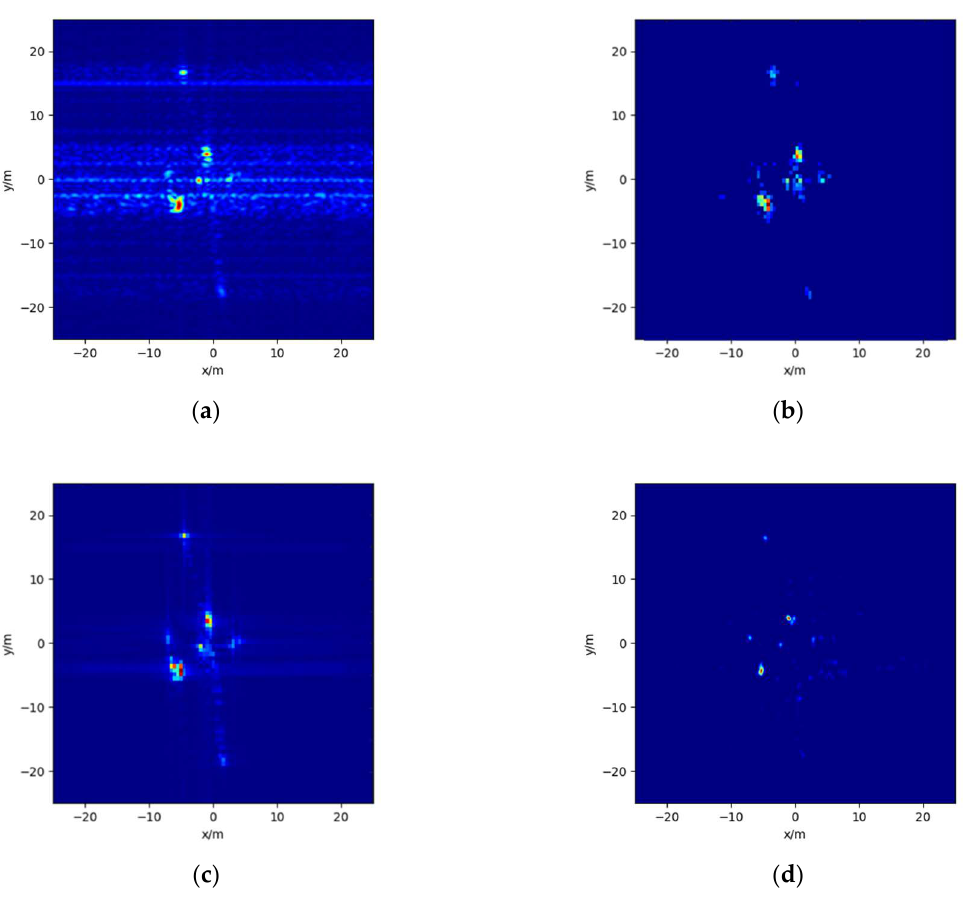
Figure 7. Imaging results of electromagnetic calculation data via comparison methods: ( a ) matched filtering method; ( b ) 1D-SR method; ( c ) MB-SL0 method; ( d ) CNN method.